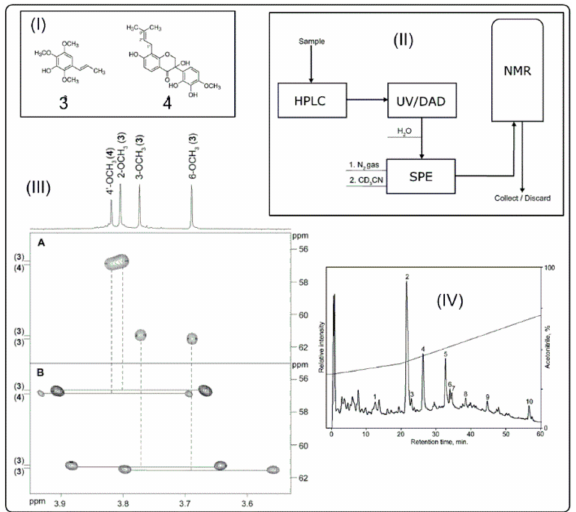
Figure 6. ( I ) Structure of extracted compounds of 3 and 4. ( II ) Instrumentation diagram of the